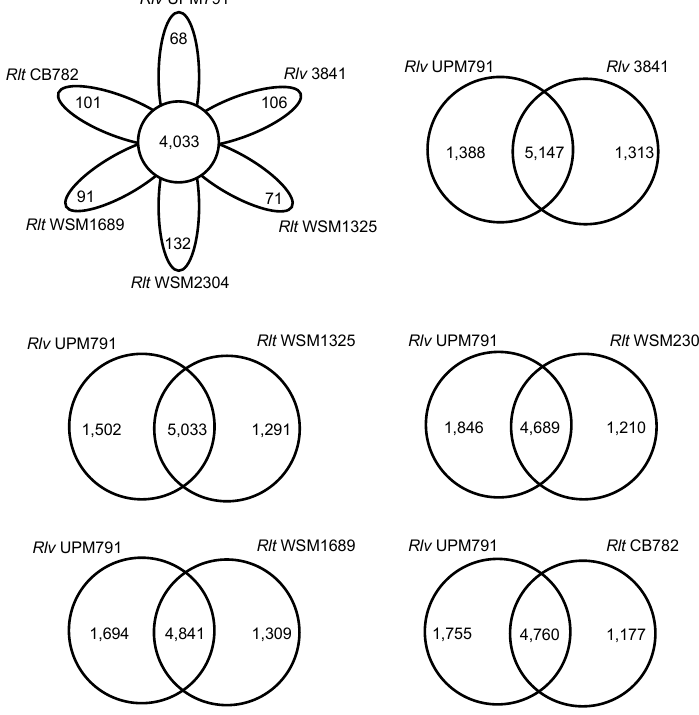
Figure 3. Venn diagram showing the number of protein families shared among strains Rlv UPM791, Rlv 3841, Rlt WSM2304, Rlt WSM1325, Rlt WSM1689, and Rlt CB782, and also between Rlv UPM791 and each of the other strains.